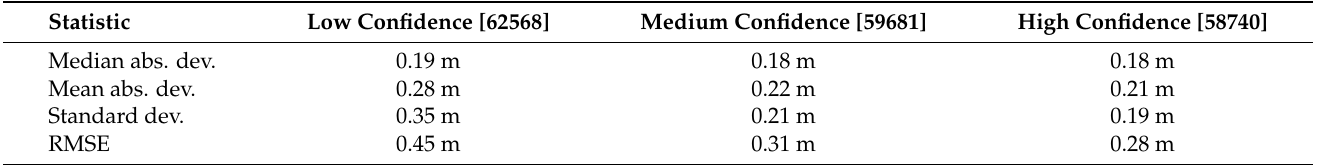
Table 2. Statistics from comparison between ICESat-2 derived bathymetry and bathymetry from determined from satellite imagery and provided by EOMAP over the Heron Reef, Australia. The values in parentheses are the number of photons used for the comparison. The statistics were calculated for four overflights with a total of 15 beams holding bathymetry signals for Heron Reef. The numbers in the table are calculated for all beams for each confidence.